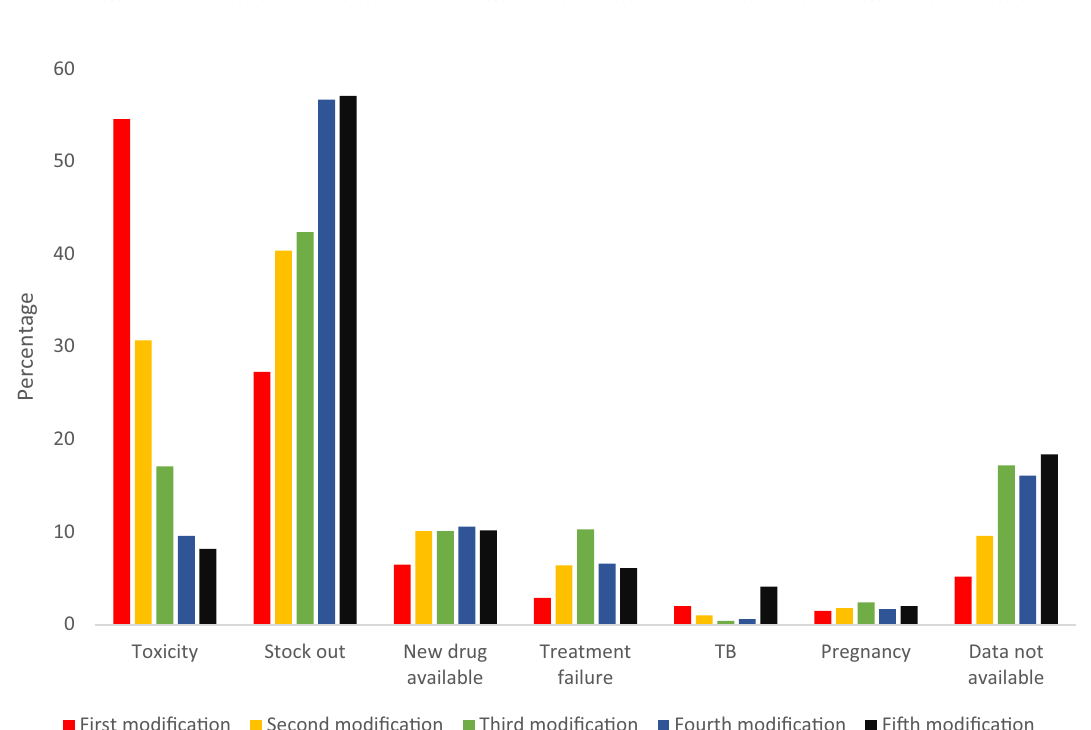
Table 1. Baseline Sociodemographic and clinical characteristics of PLWHA in hospitals of Asmara per cART regimen modification types, 2005–2021. Significant values are in bold. TDF, Tenofovir disoproxil fumarate; FTC, Emtricitabine; AZT, Zidovudine (AZT); 3TC, Lamivudine; ABC, Abacavir; D4T, Stavudine; NVP, Nevirapine; EFV, Efavirenz. NNRTI, non-nucleoside reverse transcriptase inhibitor; NRTI, nucleoside reverse transcriptase inhibitor. a Kruskal-Wallis test-1 way ANOVA test.